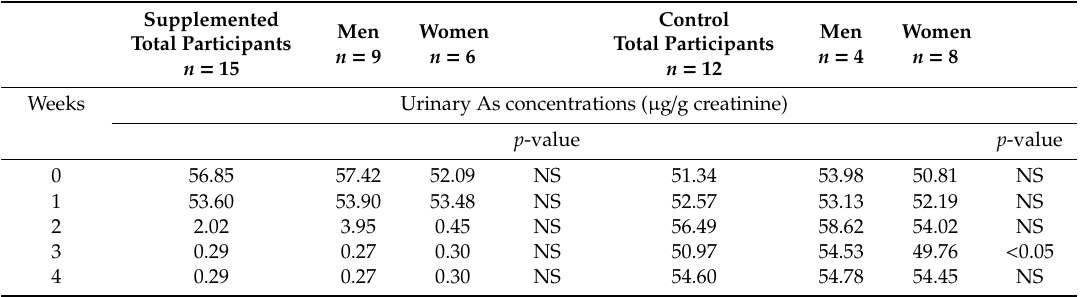
Table 7. Urinary As concentrations in the supplemented and control group during 4 weeks of